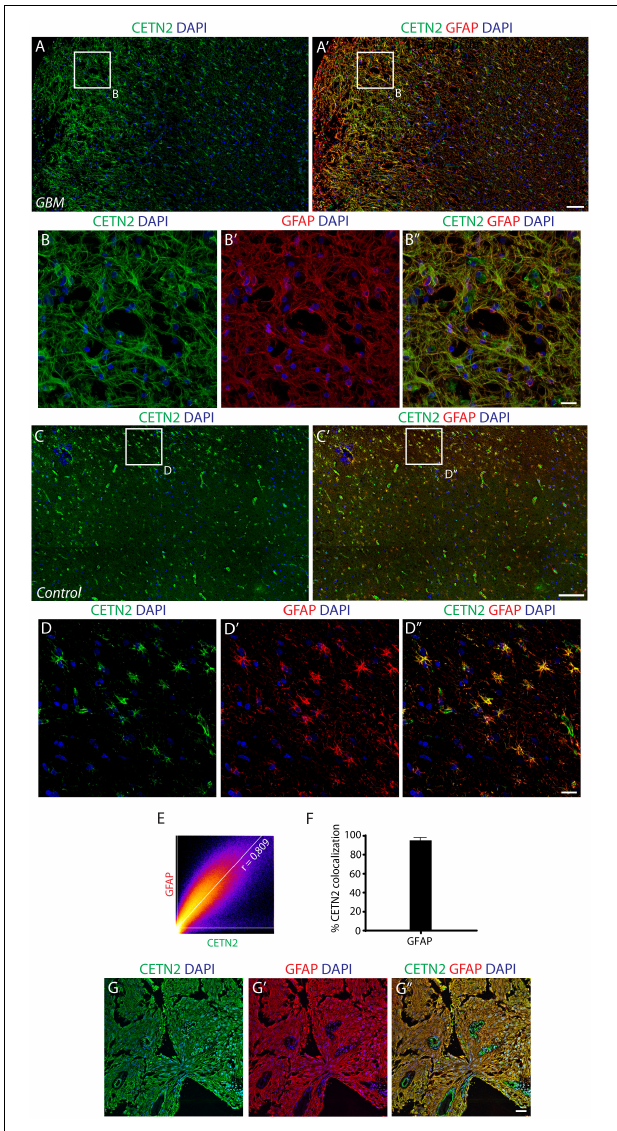
FIGURE 5 | CETN2 expression in glioblastoma multiforme (GBM). (A) Human cerebral cortex affected by GBM. Neoplastic astrocytes, magnified in (B–B”) , are immunolabeled by CETN2 and GFAP and appear densely clustered in the lesion core. (C–C’) In healthy human cerebral cortex, conversely, CETN2-positive astrocytes are uniformly dispersed in the parenchyma. (D–D”) High magnification images of healthy CETN2-positive astrocytes also display GFAP immunoreactivity. (E) Scatterplot correlation graph shows robust co-localization of CETN2 and GFAP in human GBM. (F) Histogram representing the percentage of GFAP-positive astrocytes displays CETN2 immunopositivity in GBM. Data show mean ± SEM. (G–G”) Surgically resected GBM stained for CETN2 and GFAP. Astrocytes are tightly intermingled in the tumor and display immunopositivity for both CETN2 and GFAP. Unlike GFAP, CETN2 staining also allows vessel visualization. Scale bars: (A,A’, C,C’) 100 µ m; (B–B”, D–D”, G–G”) 20 µ